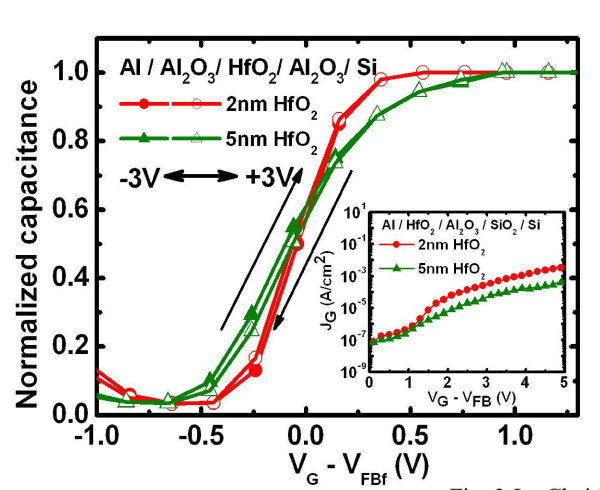
The C-V hysteresis of capacitor structure Al/HfO2/Al2O3/SiO2/Si for two different HfO2 thicknesses. Inset shows the J-V characteristic of the same capacitor structure. The gate voltage of the C-V hysteresis was swept from -3 to +3 V and then swept back. All the gate voltages were normalized with the VFB of the forward (-3 to +3V) C-V curve (VFBf).